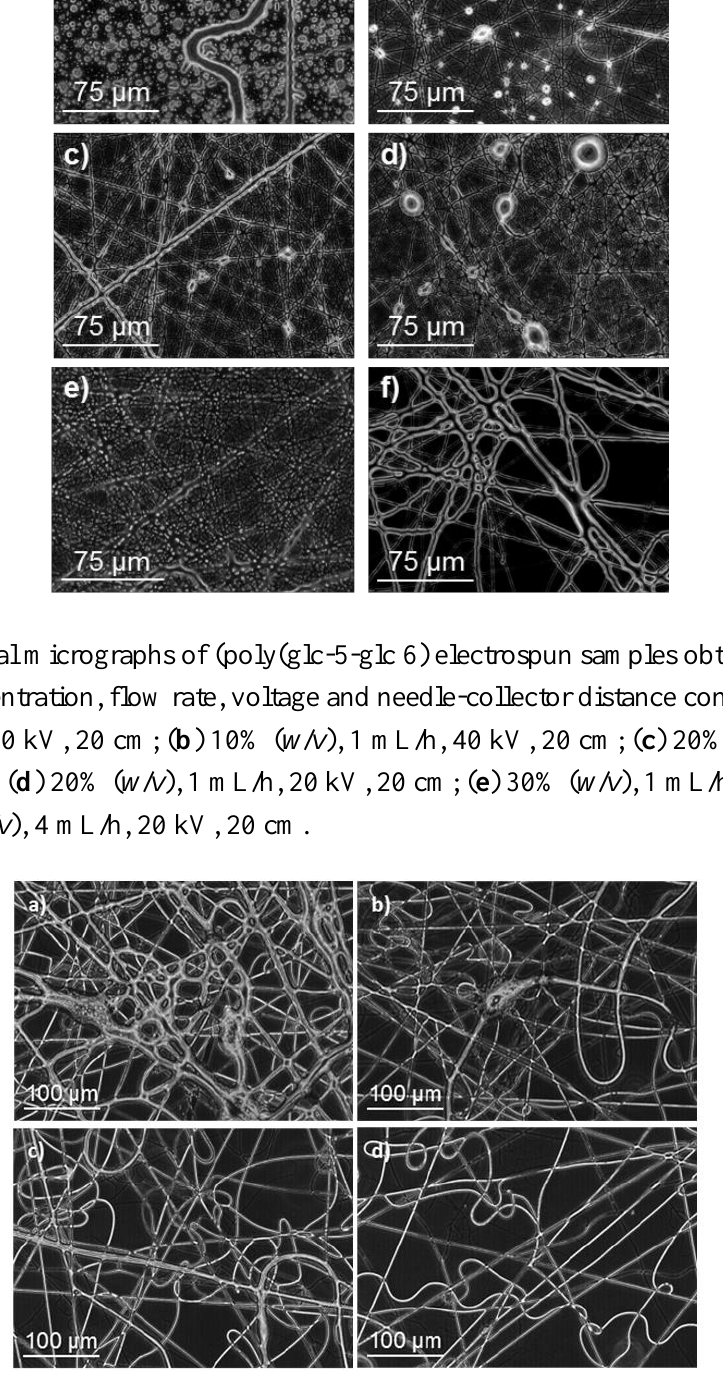
Figure 3. Optical micrographs of poly(glc-6-glc 6) electrospun samples obtained under the following concentration, flow rate, voltage and needle-collector distance conditions: ( a ) 50% ( w / v ), 3 mL/h, 15 kV, 20 cm; ( b ) 50% ( w / v ), 1.5 mL/h, 10 kV, 20 cm; ( c ) 50% ( w / v ), 1 mL/h, 20 kV, 29 cm and ( d ) 50% ( w / v ), 1 mL/h, 15 kV, 20